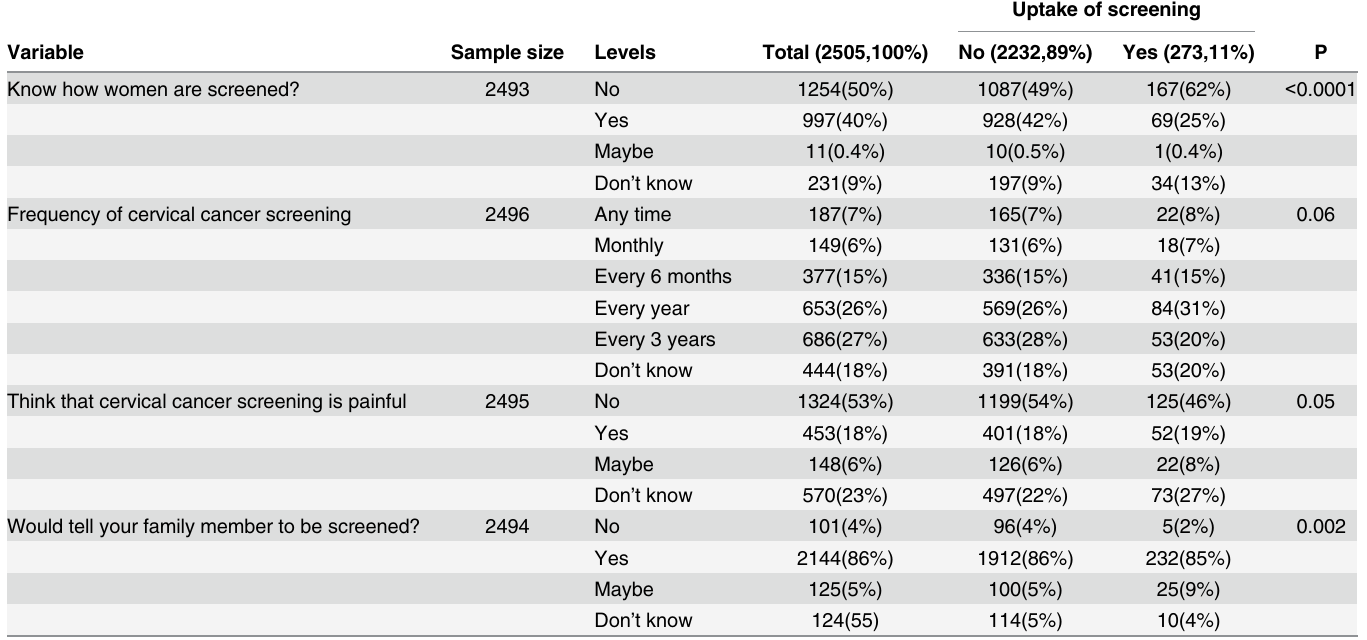
Table 3. Knowledge about cervical cancer